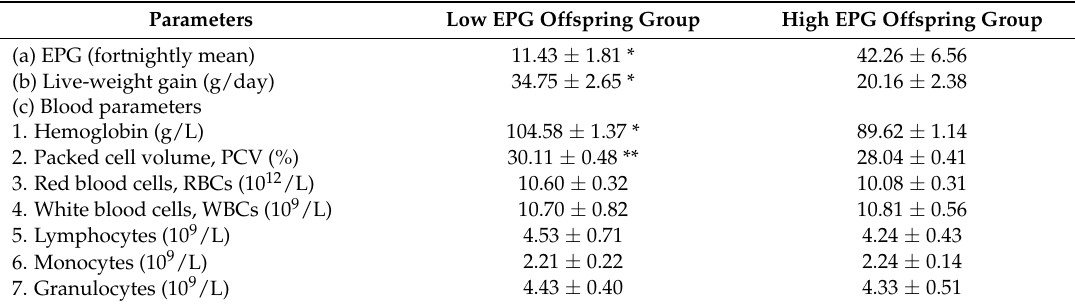
Table 1. Weight gain, egg per gram (EPG), and blood parameters comparison of low EPG offspring group and high EPG offspring group of Yichang White Goats (YWGs) ( n = 122).